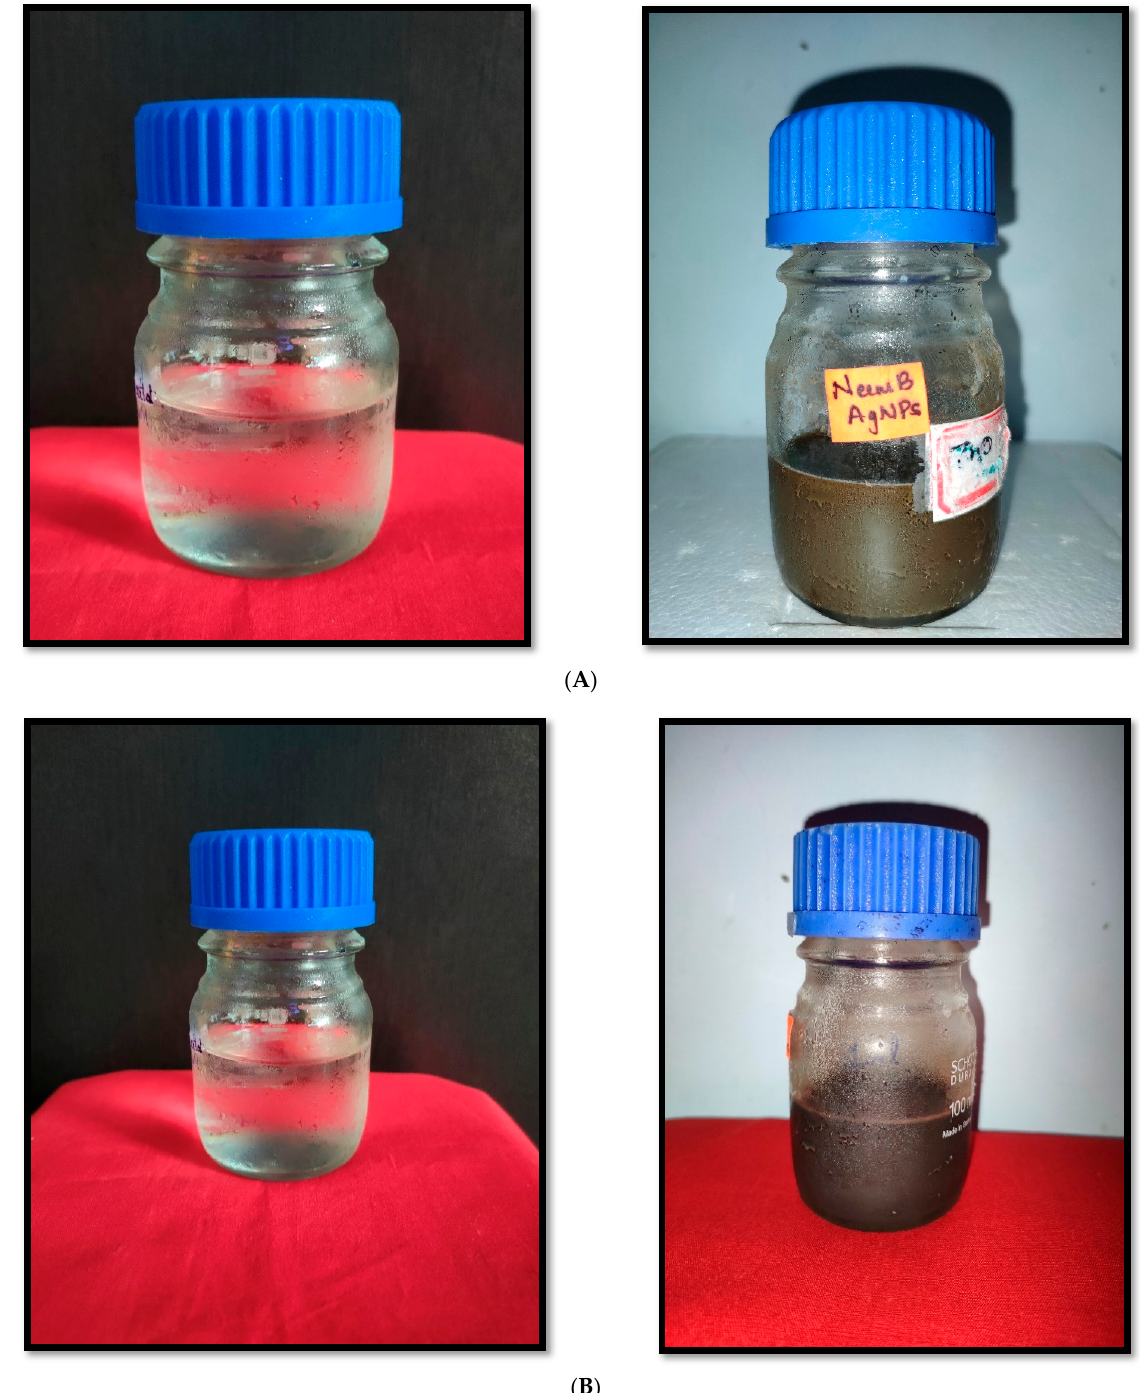
Figure 1. ( A ) Color variation of A. indica -silver nitrate solution after silver nanoparticle formation. ( B ). Color variation of P. pinnata -silver nitrate solution after silver nanoparticle formation.